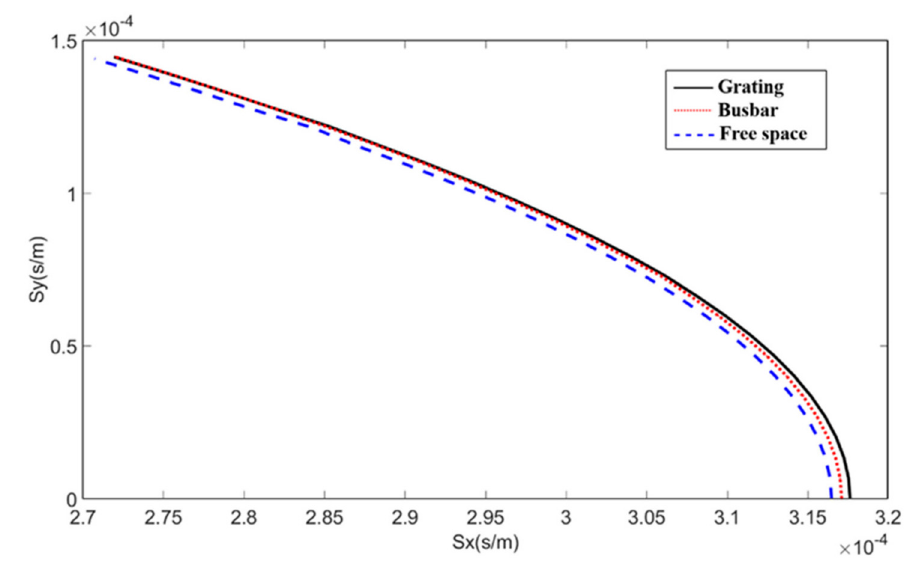
Figure 3. Slowness curves of each region of the TC-SAWR device. The values of γ 1 and γ 2 in different regions were further obtained, as shown in Table